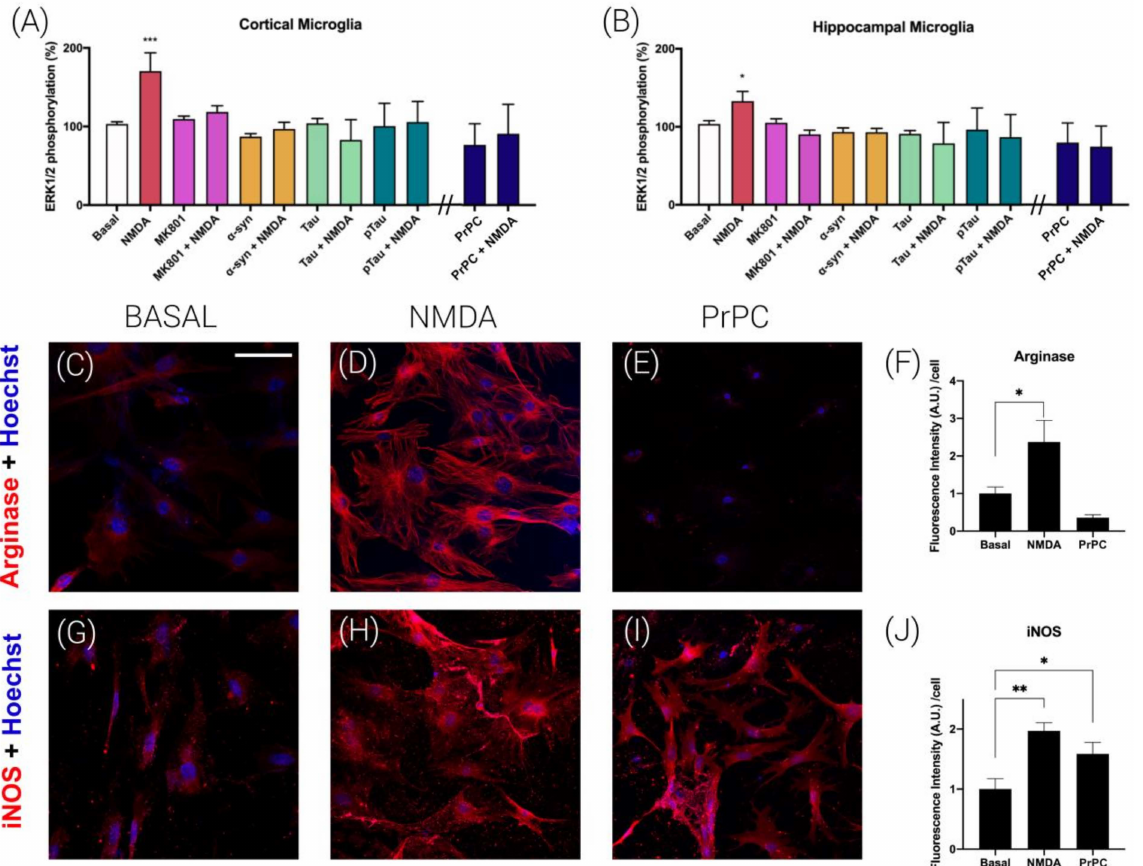
Figure 4. NMDAR-PrPC complexes effect on MAPK signaling in microglial primary cultures from mice. Analysis of proinflammatory (M1) and anti-inflammatory (M2) states of microglia. ERK1/2 phosphorylation was analyzed using an AlphaScreen ® SureFire ® kit (Perkin Elmer) in cortical ( A ) or hippocampal ( B ) microglial cells. Primary cultures were treated with vehicle (white) or NMDA (red), or pretreated with the selective NMDAR antagonist MK-801 (1 µ M, purple), alpha-synuclein (4 µ M, orange), Tau (1 µ M, green) or pTau (1 µ M, dark green) prior to NMDA addition (15 µ M). Cells transfected with the cDNA for the human PrPC (blue, 1 µ g) were treated with NMDA (15 µ M) or vehicle. Values are the mean ± S.E.M. of 5 independent experiments performed in triplicate. One-way ANOVA followed by Bonferroni’s multiple comparison post hoc test was used for statistical analysis (* p < 0.05, ** p < 0.01, *** p < 0.001 versus basal condition). ANOVA summary: ( A ) F: 8.36 p < 0.001. ( B ) F: 6.38 p < 0.001. Immunocytochemistry assays were performed in hippocampal primary microglia. Cells were treated with NMDA (15 µ M) or vehicle (basal) for 1 h more. Cells were transfected with human PrPC cDNA ( E , I ) (1 µ g) or vehicle (basal). The microglia phenotype was characterized by incubating with specific antibodies: anti-Arginase, microglia M2 state ( C – F ) or anti-iNOS, microglia M1 state ( G – J ). Detection is shown in red due to incubation with a secondary antibody conjugated to ALEXA FLUOR ® 561. Bar graphs ( F , J ) represent the quantification of the red labeling (fluorescence intensity A.U./cell) in the different groups calculated using Fiji software. Values are the mean ± S.E.M. of 5 independent experiments performed in triplicate. One-way ANOVA followed by Bonferroni’s multiple comparison post hoc test was used for statistical analysis (* p < 0.05, ** p < 0.01; versus basal condition fluorescence intensity). ANOVA summary: ( F ) F: 12.52 p < 0.001. ( J ) F: 25.53 p < 0.001. Scale bar: 75 µ